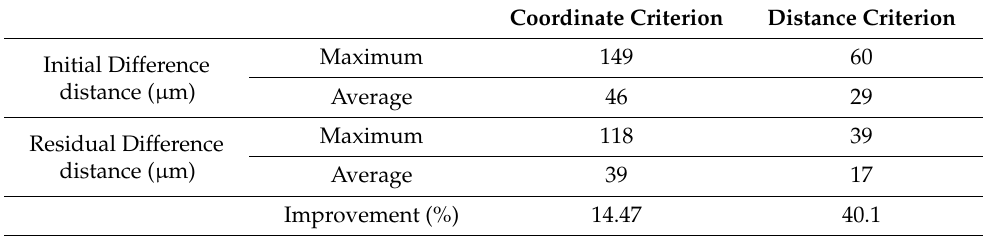
Table 3. Model behavior in the calibration procedure for different criteria.